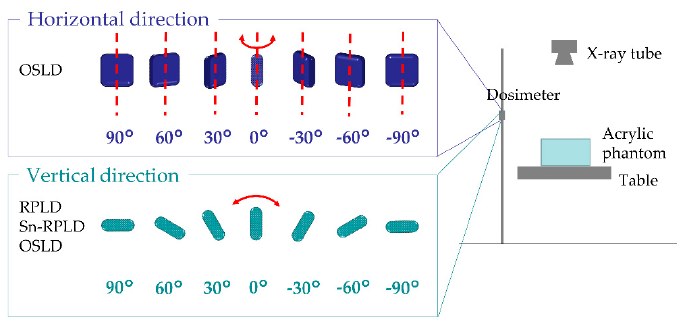
Figure 2. An experimental setup for evaluating the directional dependence of small dosimeters. The RPLD or Sn-RPLD was tilted vertically from − 90 ◦ to 90 ◦ at intervals of 30 ◦ and the OSLD was